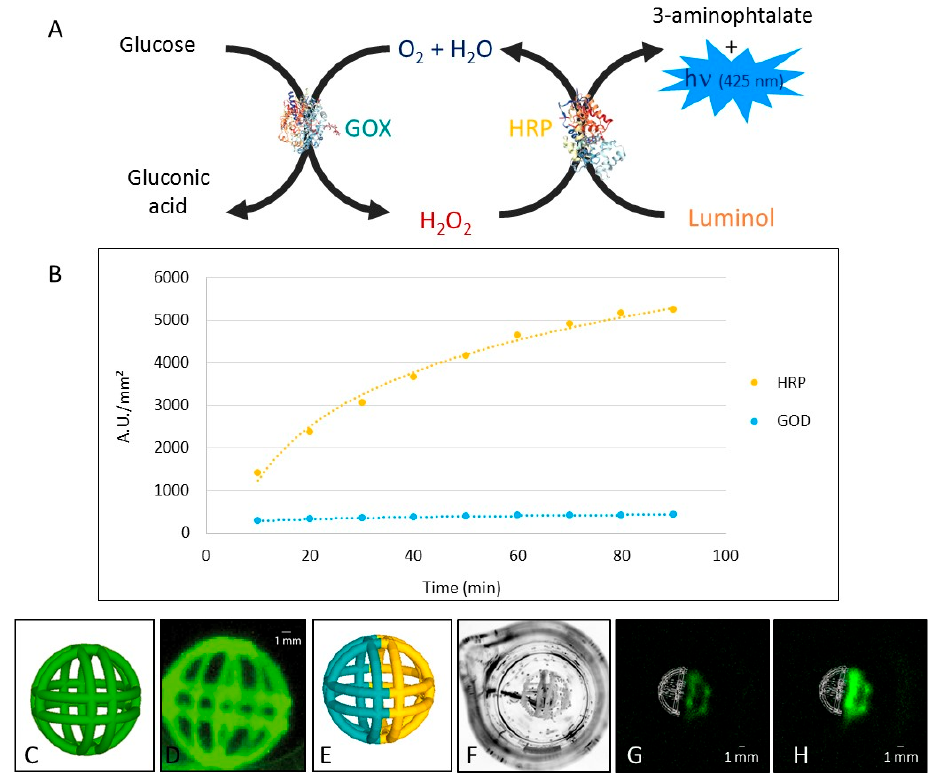
Figure 4. Bi-enzyme chemiluminescent system. ( A ) Glucose oxidase and horseradish peroxidase are working sequentially to produce light in the presence of glucose and luminal; ( B ) chemiluminescent signal over time. Yellow curve corresponds to the signal measures on the horseradish peroxidase (HRP) half-ball and the blue one to the signal measures on the glucose oxidase (GOD) half ball; ( C ) a homogeneous fanciful ball composed of glucose oxidase and peroxidase is used; ( D ) chemiluminescent image of the homogeneous fanciful ball in the presence of glucose 100 mM and luminol 220 µ M (180 s integration); ( E ) a heterogeneous fanciful ball composed of glucose oxidase (left) and peroxidase (right) is used; ( F ) visible light image of the heterogeneous fanciful ball; ( G ) chemiluminescent image of the homogeneous fanciful ball in the presence of glucose 100 mM and luminol 220 µ M (600 s integration, 60 and 90 min after substrates addition left ( G ) and right ( H ), respectively).